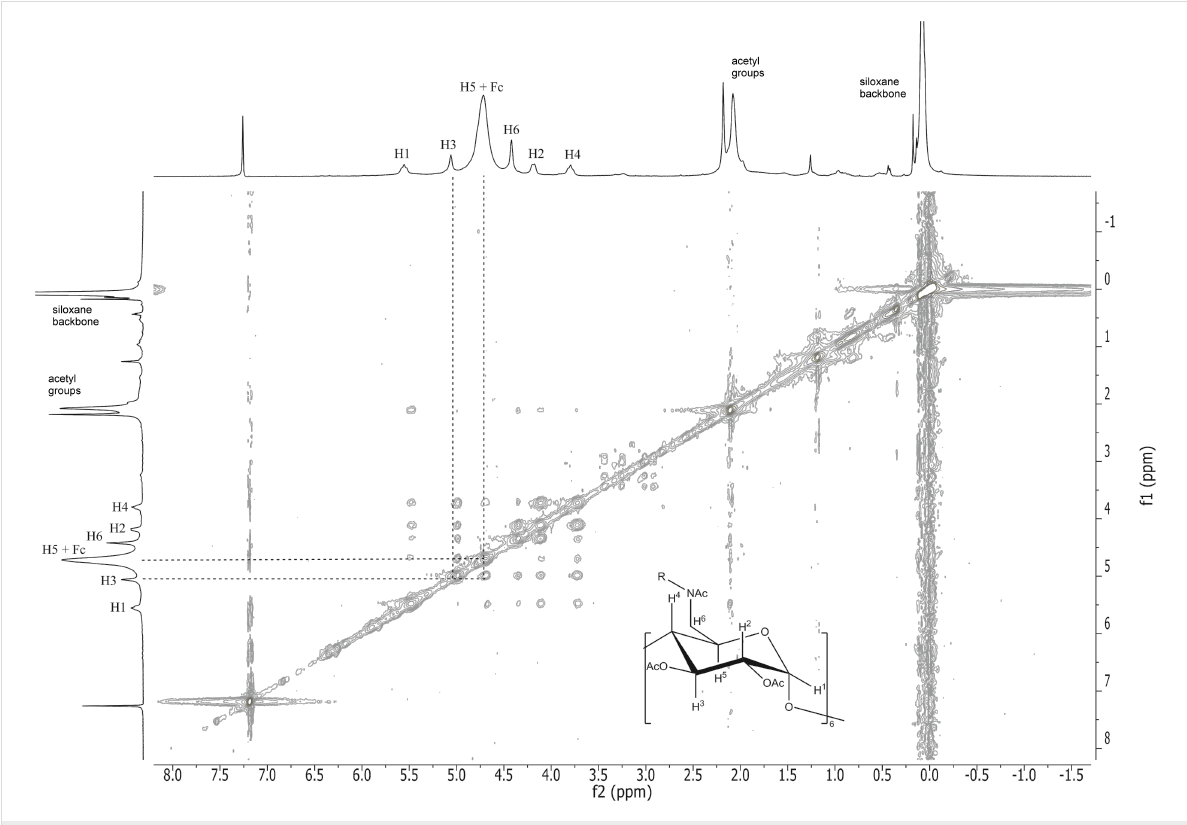
Figure 4: 2D ROESY NMR spectra of the complex of α -CD-polydimethylsiloxane ( α -CD-PDMS) 5 with ferrocene.